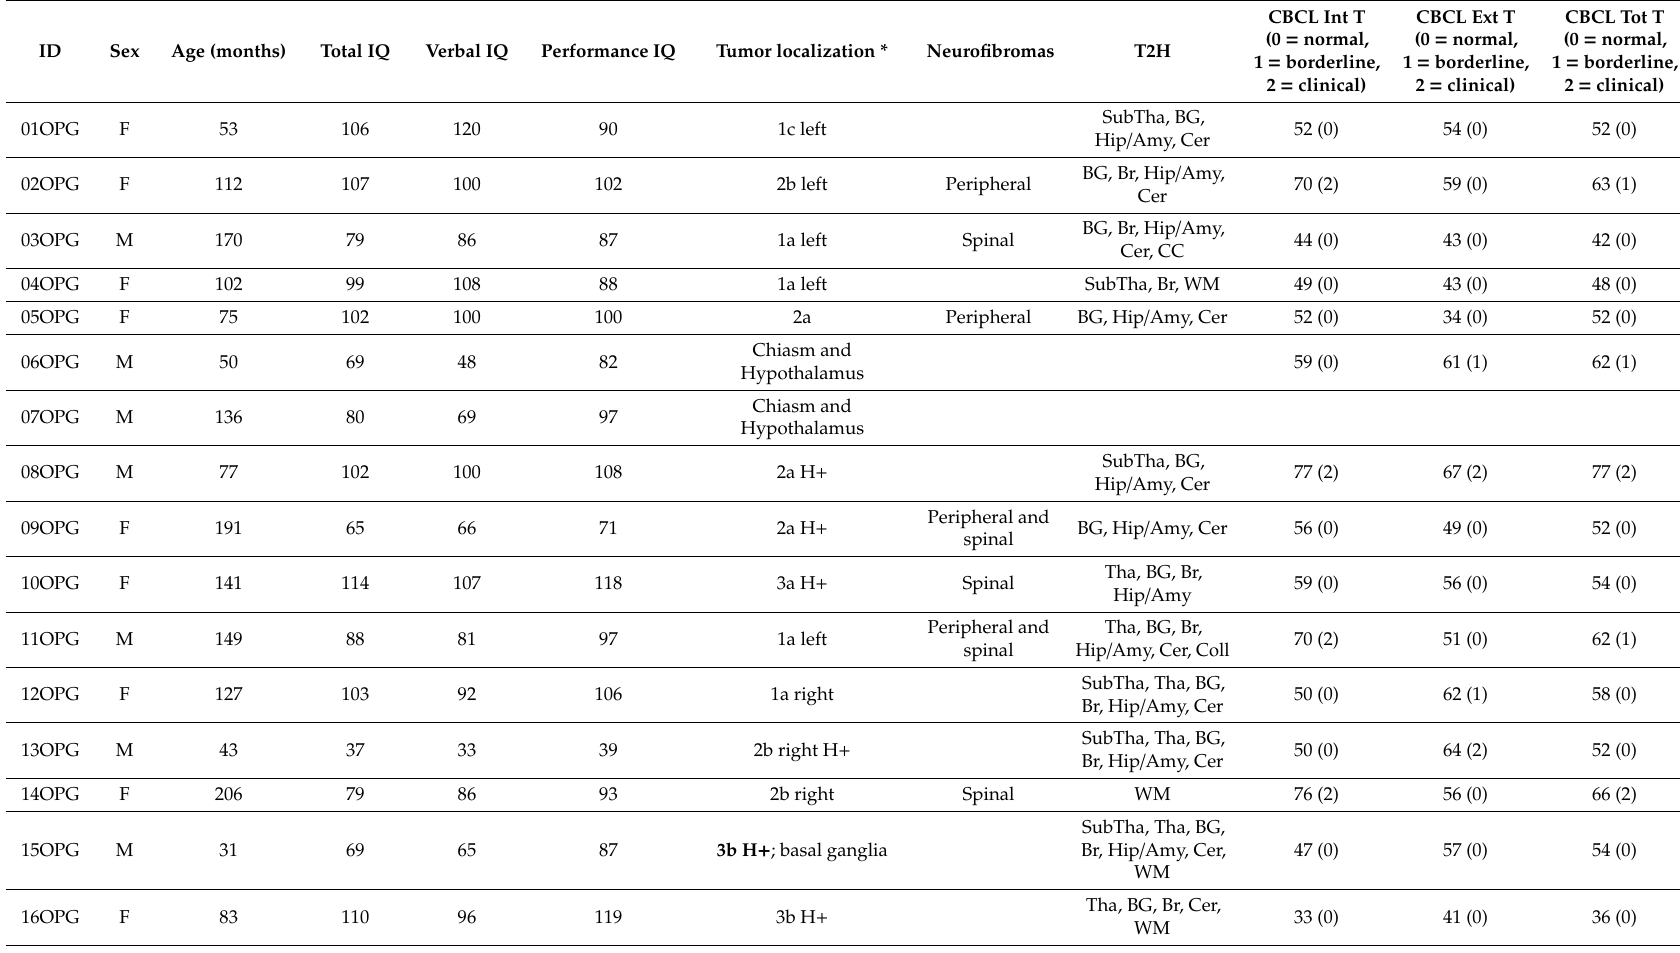
Table 6. Clinical characteristics of patients with NF1 and Optical Pathways